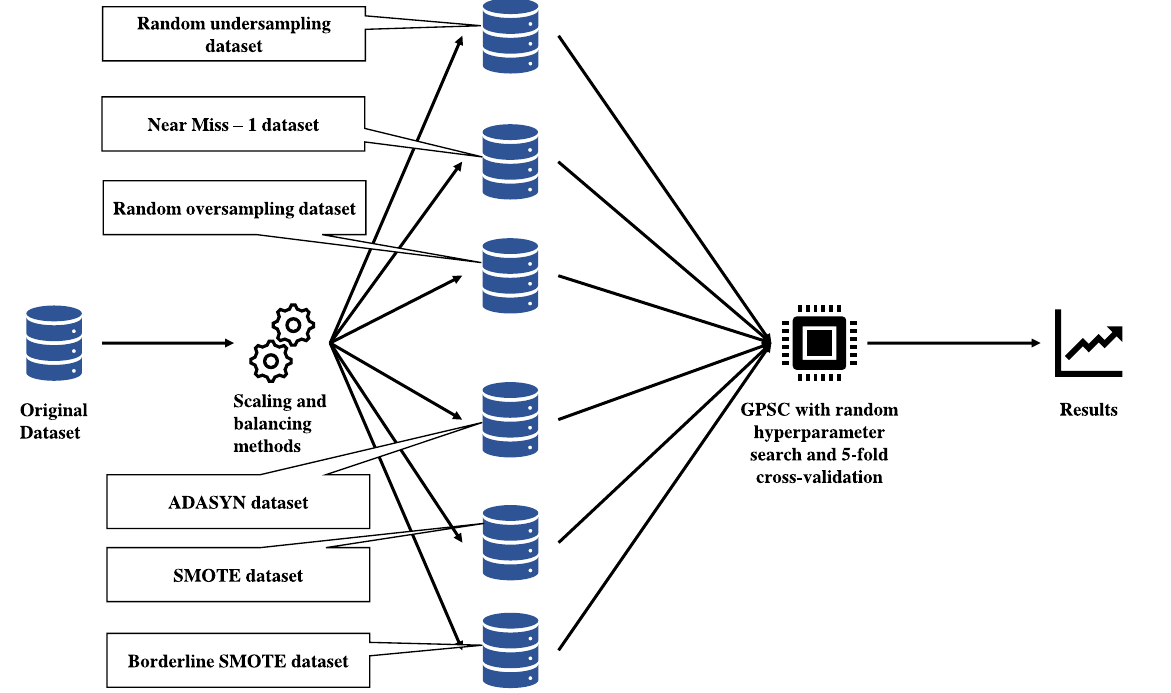
Figure 1. The schematic view of research